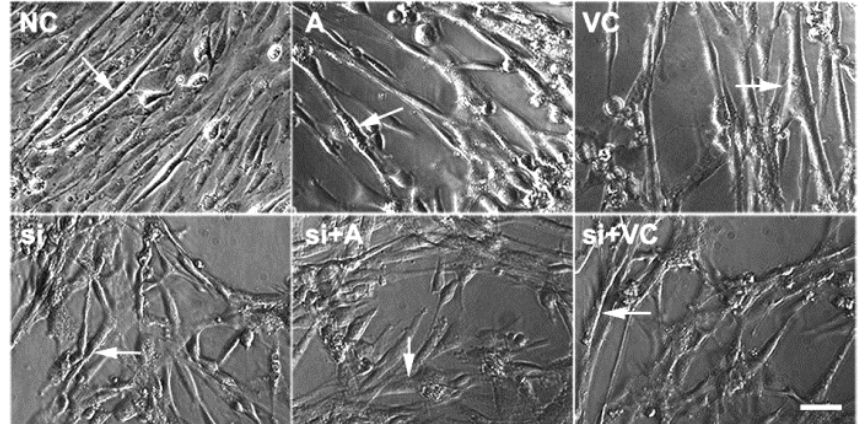
Figure 2. 5-AZA and VC facilitated myoblast differentiation. Myoblasts treated with 5-AZA and VC were induced differentiation, and the morphology of myotubes was detected. Arrows indicate differentiated myotubes; Scale bar: 50 μm.